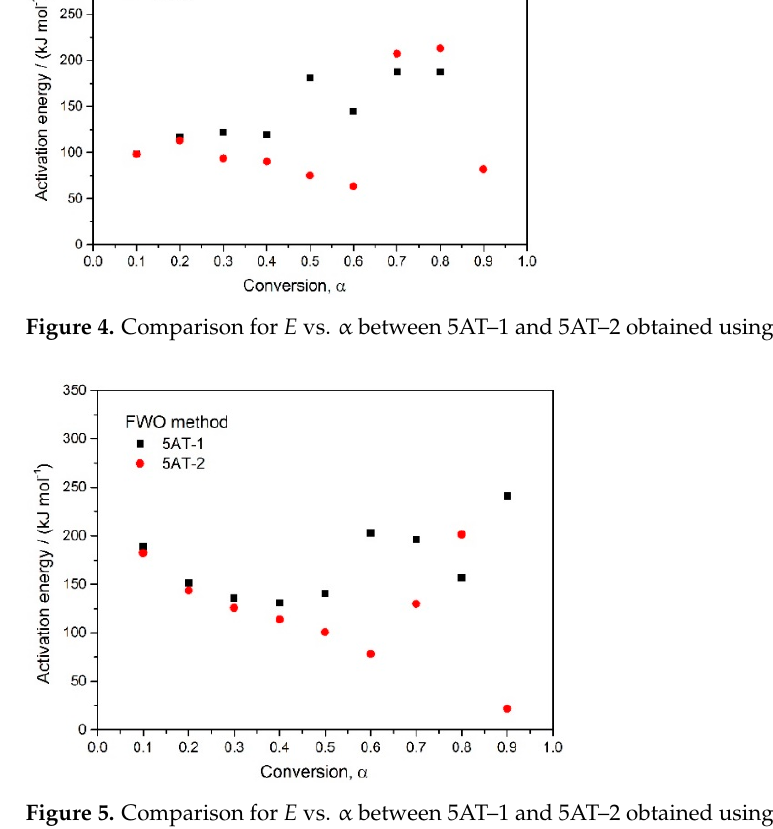
Figure 5. Comparison for E vs. α between 5AT–1 and 5AT–2 obtained using FWO method.